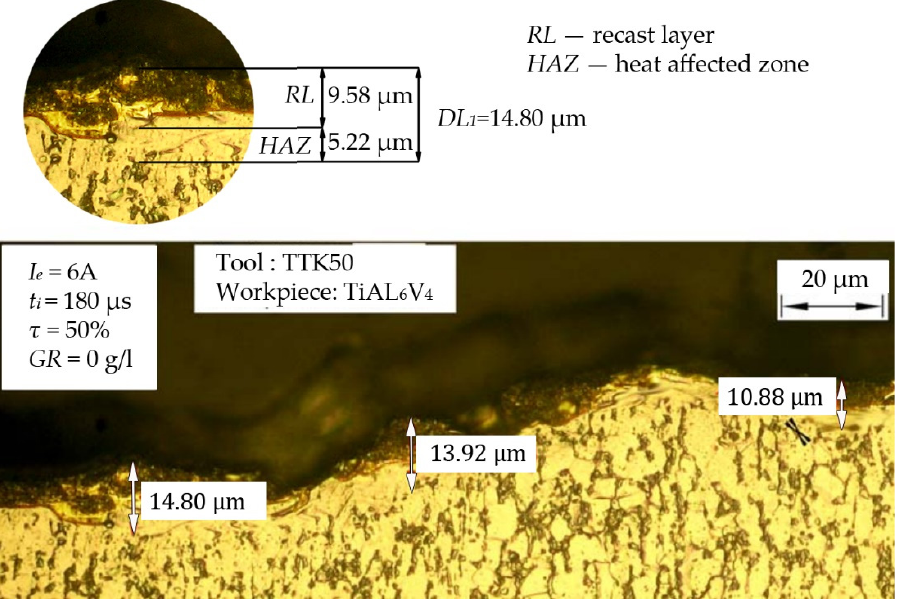
Figure 3. Thickness of the defect layer for the first measurement.